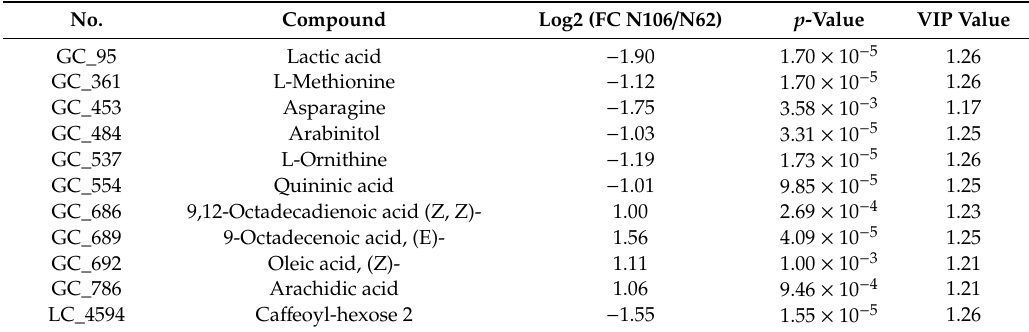
Table 1. Di ff erential metabolites extracted from S15k0106 (N106) seeds and S13k0062 (N62) seeds.